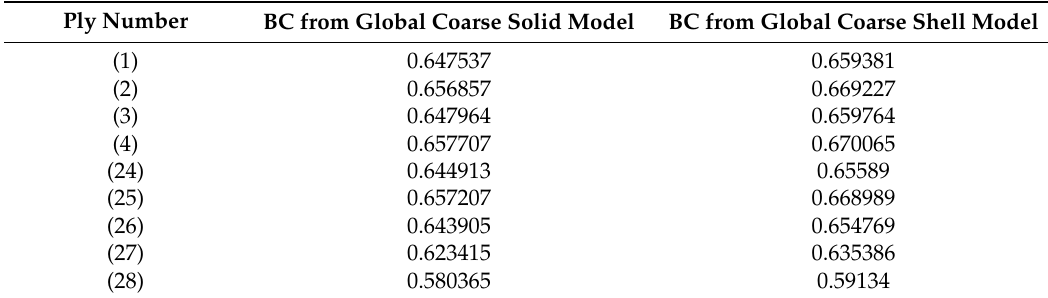
Table 6. Comparison between failure indexes from local models with BCs taken from global coarse shell and solid models.